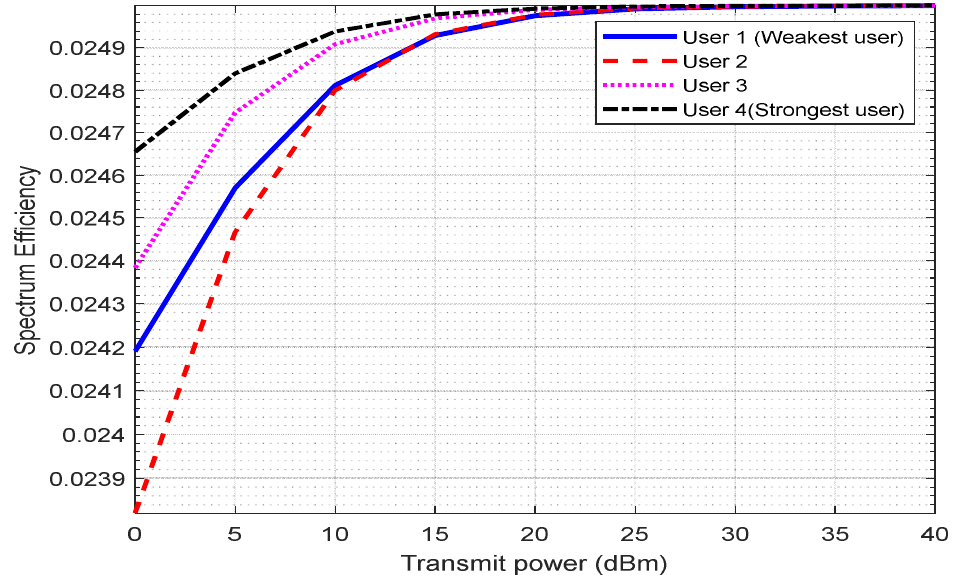
Figure 9. SE vs. transmitting power for four users with varying distances, with power coefficients, with the 64 × 64 MIMO and BW 80 MHz for DL NOMA.